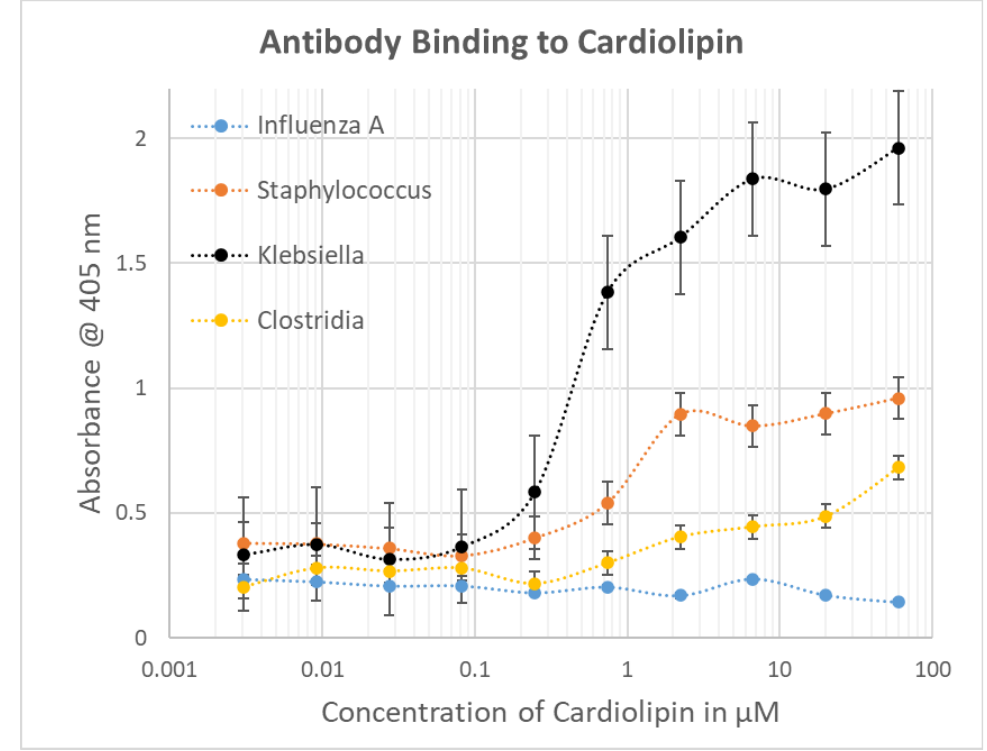
Figure 7. Bacterial antibody binding to cardiolipin..